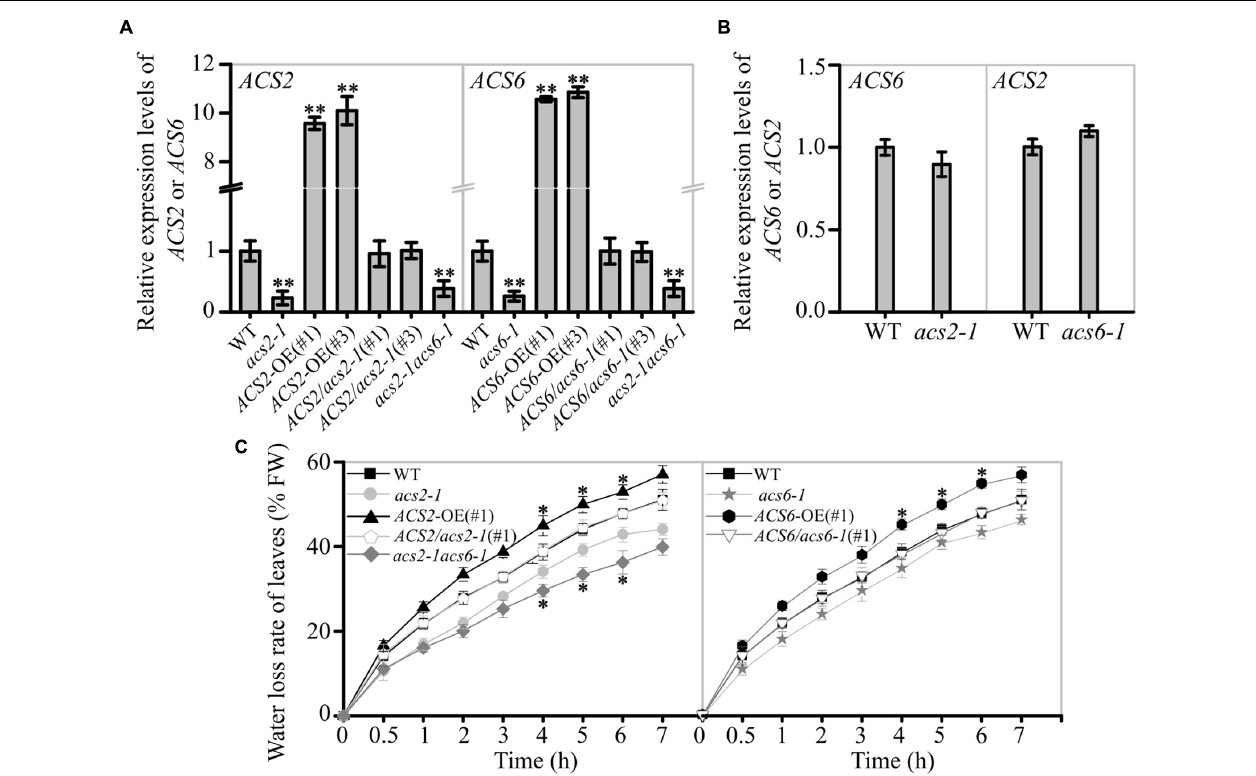
FIGURE 1 | Effect of ACS2/6 expression on water loss from leaves of Arabidopsis seedlings. (A) RT-qPCR analysis of ACS2 and ACS6 mRNA levels in various lines, including the WT; loss-of-function mutants acs2-1 , acs6-1 , and acs2-1acs6-1 ; overexpression lines ACS2 -OE(#1), ACS2 -OE(#3), ACS6 -OE(#1), and ACS6 -OE(#3); and complementation lines ACS2 / acs2-1 (#1), ACS2 / acs2-1 (#3), ACS6 / acs6-1 (#1), and ACS6 / acs6-1 (#3). ACTIN8 was used as a reference gene. Experiments were repeated three times. Values are means ± SD (Student’s t -test; ∗∗ P < 0.01). (B) RT-qPCR analysis of ACS6 mRNA level in acs2-1 and ACS2 mRNA level in acs6-1 . Experiments were repeated three times with similar results. (C) Relative rate of water loss over time from detached rosette leaves of 28-day-old plants. All true leaves of five plants of the same line grown under identical conditions were collectively weighed every hour. The data represent the water loss percentage at a given time point, calculated as follows: [(initial weight – weight at each time point)/initial weight] × 100. Experiments were repeated at least three times with similar results. Values are means ± SD (Student’s t -test; ∗ P <